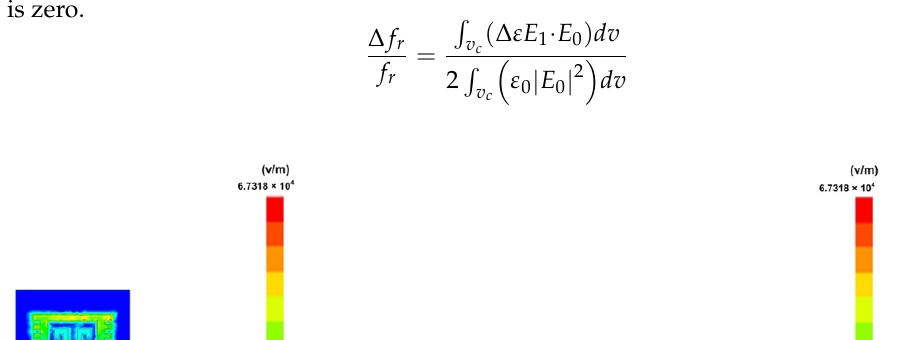
Figure 3. Simulation result of sensor without MUT loaded.